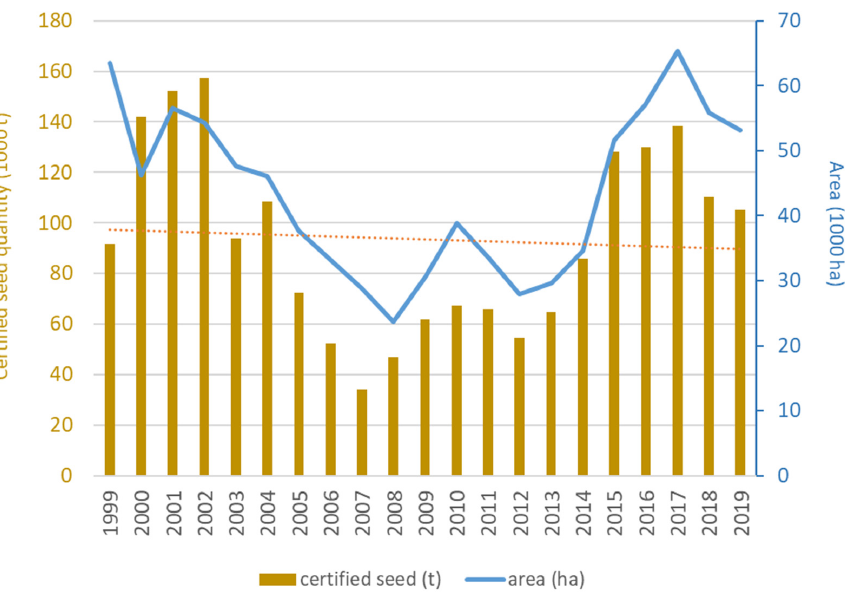
Figure 8. Area of field pea seed production and amount of certified seeds between 1999–2019 in the EU member states [65].